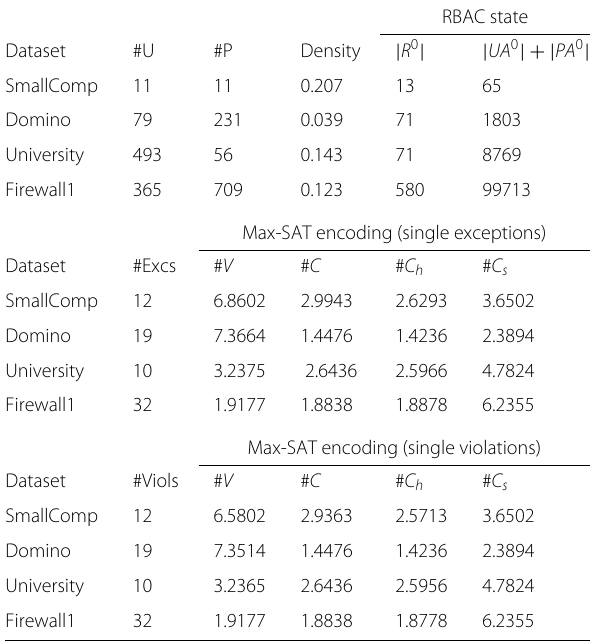
Table 4 Datasets in our benchmark: single exceptions and